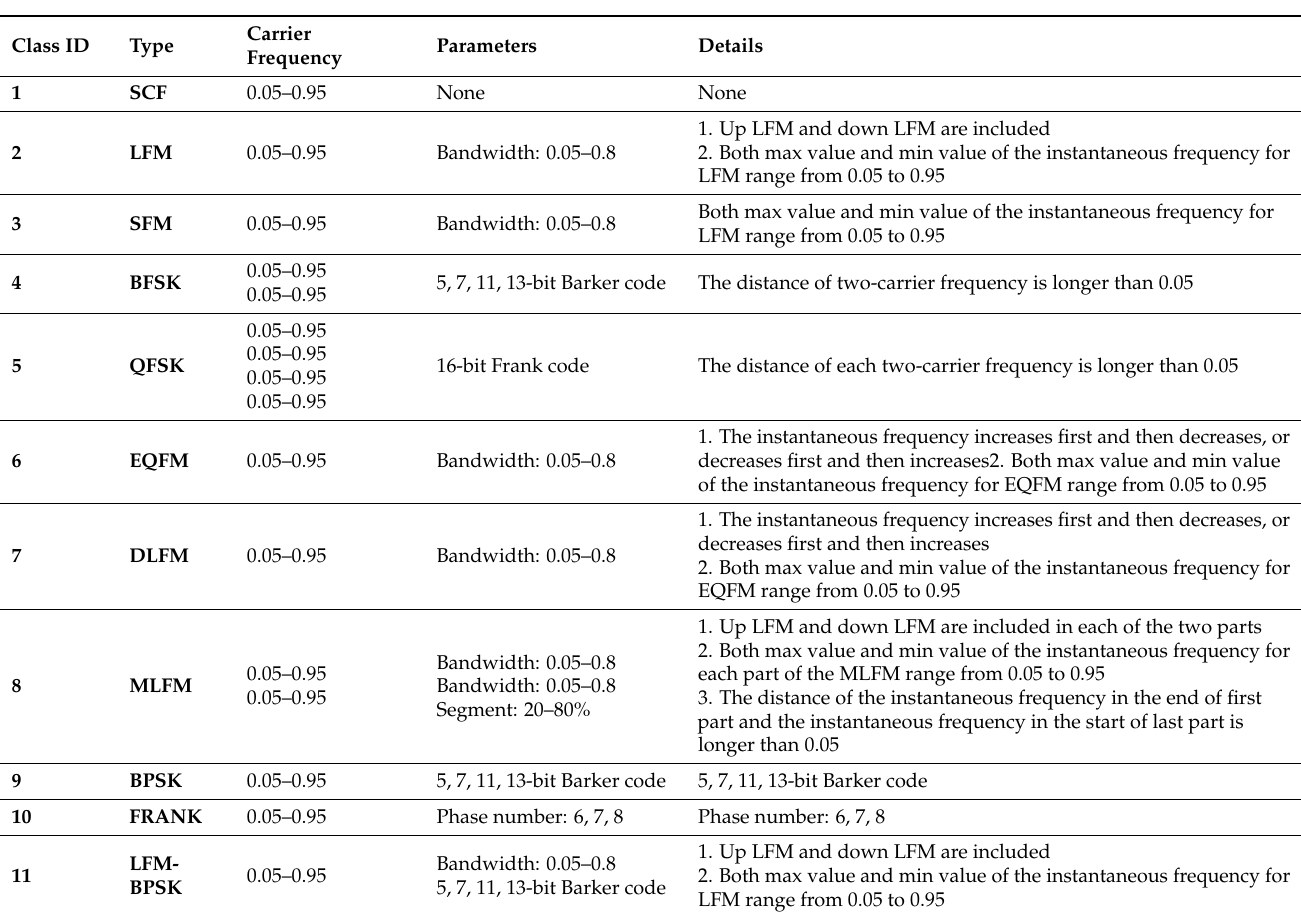
Table 1. Parameters of radar emitter signals with eleven different intra-pulse